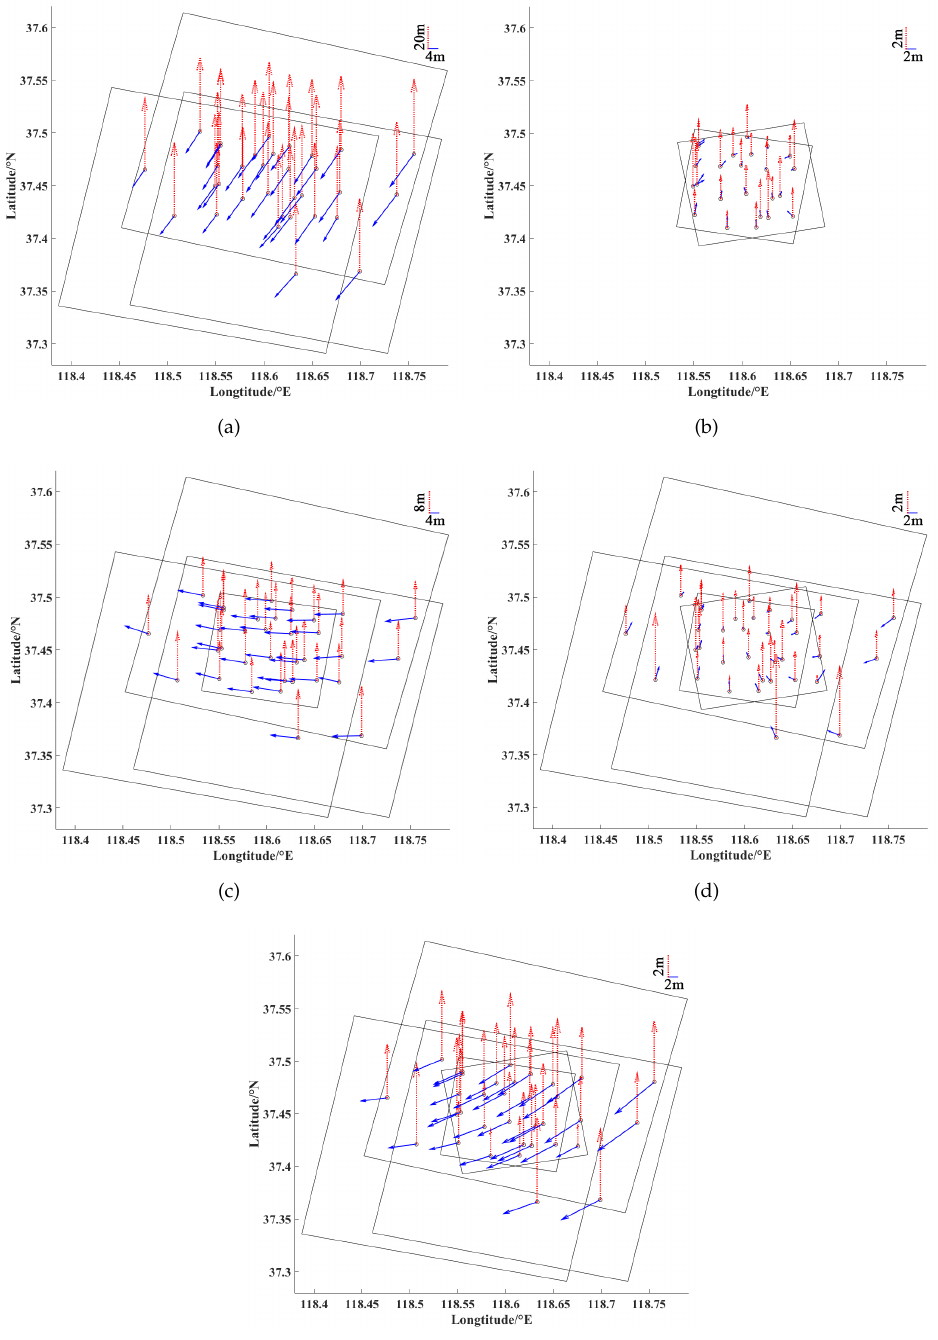
Figure 6. Geometric accuracy analysis of GF2 and GF3: ( a ) GF2 geopositioning, ( b ) GF3 geopositioning. ( c ) GF2 + GF3-1 combined geopositioning, ( d ) GF2 + GF3-1 + GF3-2 combined geopositioning, and ( e ) GF2 + GF3-1 + GF3-2 combined geopositioning with the same weight. Check points (CKPs) are represented by circles. The plane error and altitude error are represented by the vectors marked by the solid line and the dotted line,